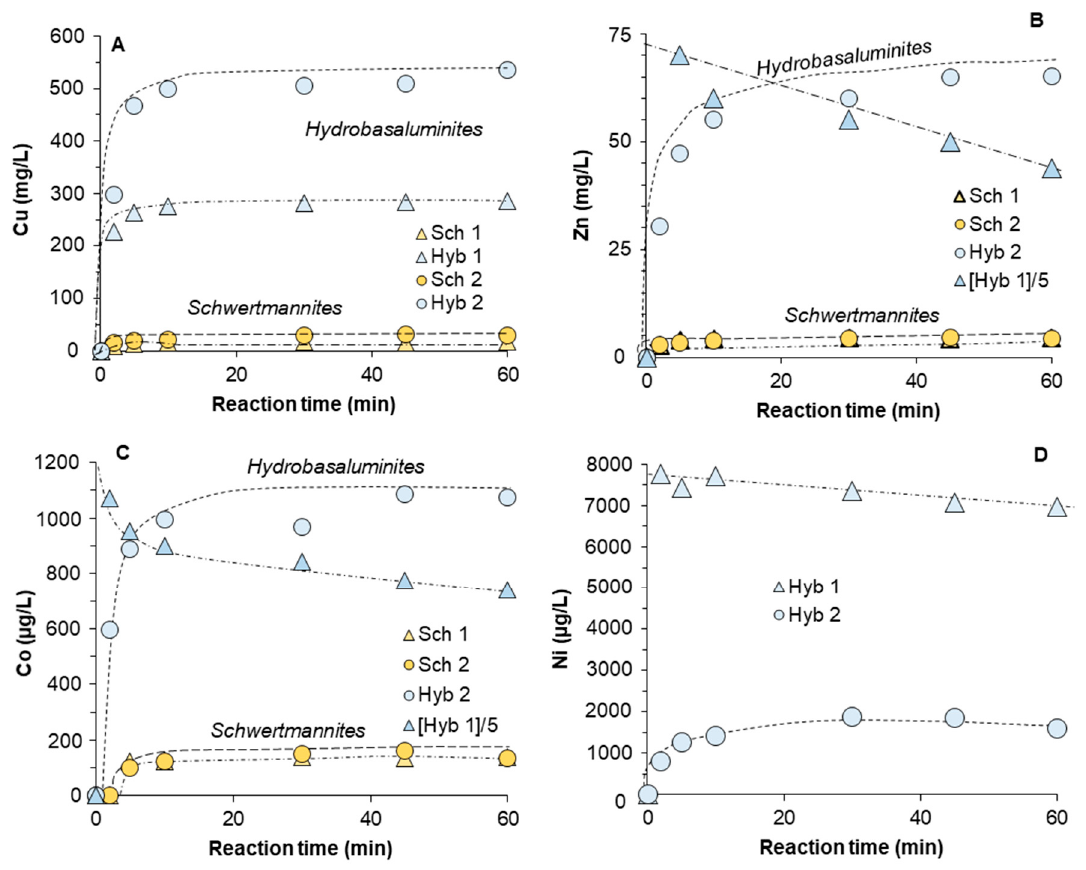
Figure 4. Release of Cu ( A ), Zn ( B ), Co ( C ) and Ni ( D ) during dissolution in ammonium oxalate (pH 3.0) using either schwertmannite (Sch 1, Sch 2) or hydrobasaluminite (Hyb 1, Hyb 2).